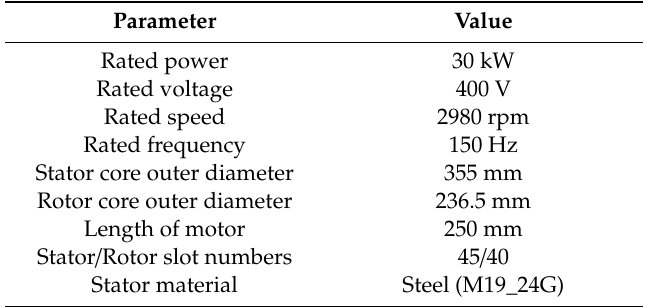
Table 2. Design parameters of Radial Flux Induction Motor (RFIM).